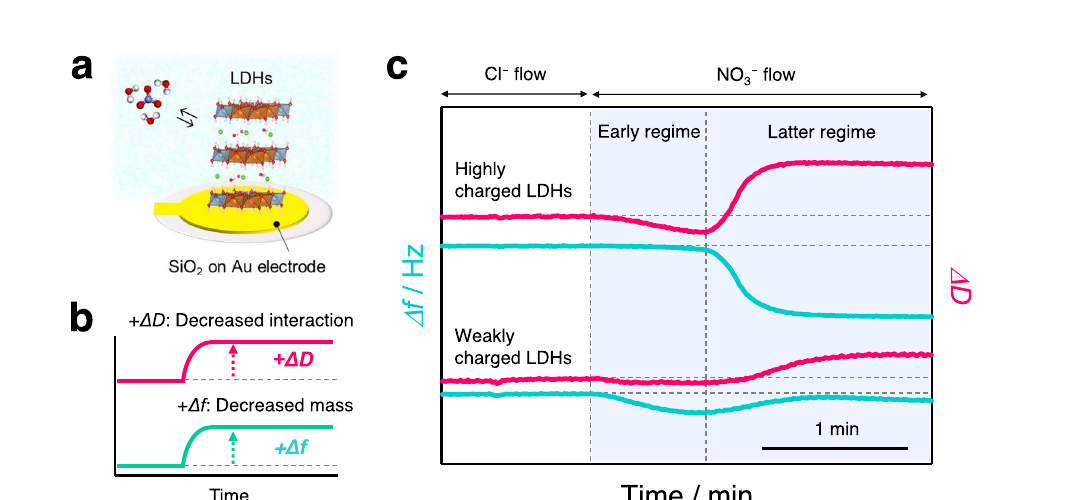
fi lms with x =0.28 and 0.22 show the change in the frequency ( Δ f ) and dissipation ( Δ D ) upon changing the test solution from aqueous NaCl solution to NaNO 3 solu- tion.The fl owrateissetto300 μ Lmin – 1 .Sourcedatafor c areprovidedasaSource Data fi